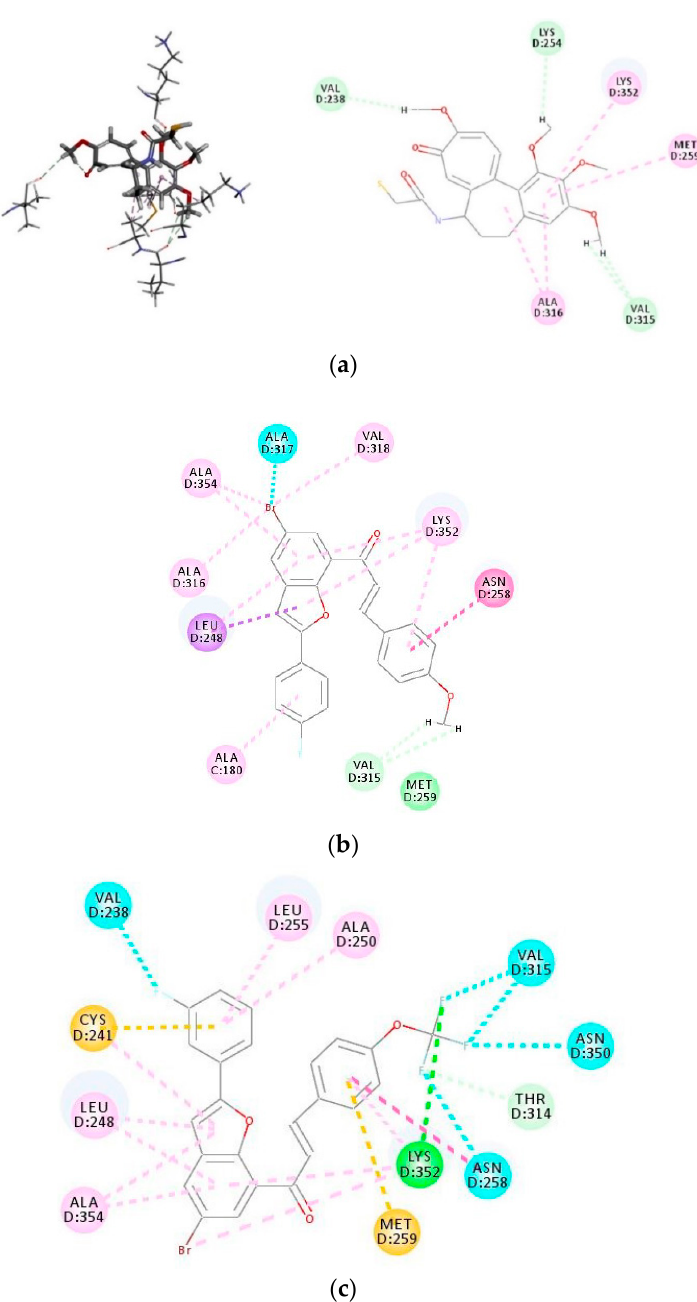
Figure 6. ( a ) 2D interaction diagrams for the binding of tubulin (PDB code: 1SAO) with colchicine; ( b ) the structure of ( E )-1-(5-Bromo-2-(4-fluorophenyl)benzofuran-7-yl)-3-(4-methoxyphenyl)prop-2-en-1-one ( 3i ); ( c ) the structure of ( E )-1-(5-Bromo-2-(3-fluorophenyl)benzofuran-7-yl)-3-(4-(trifluoromethoxy)phenyl)prop-2-en-1-one ( 3o ). Residues are annotated with their three-letter amino acid code.